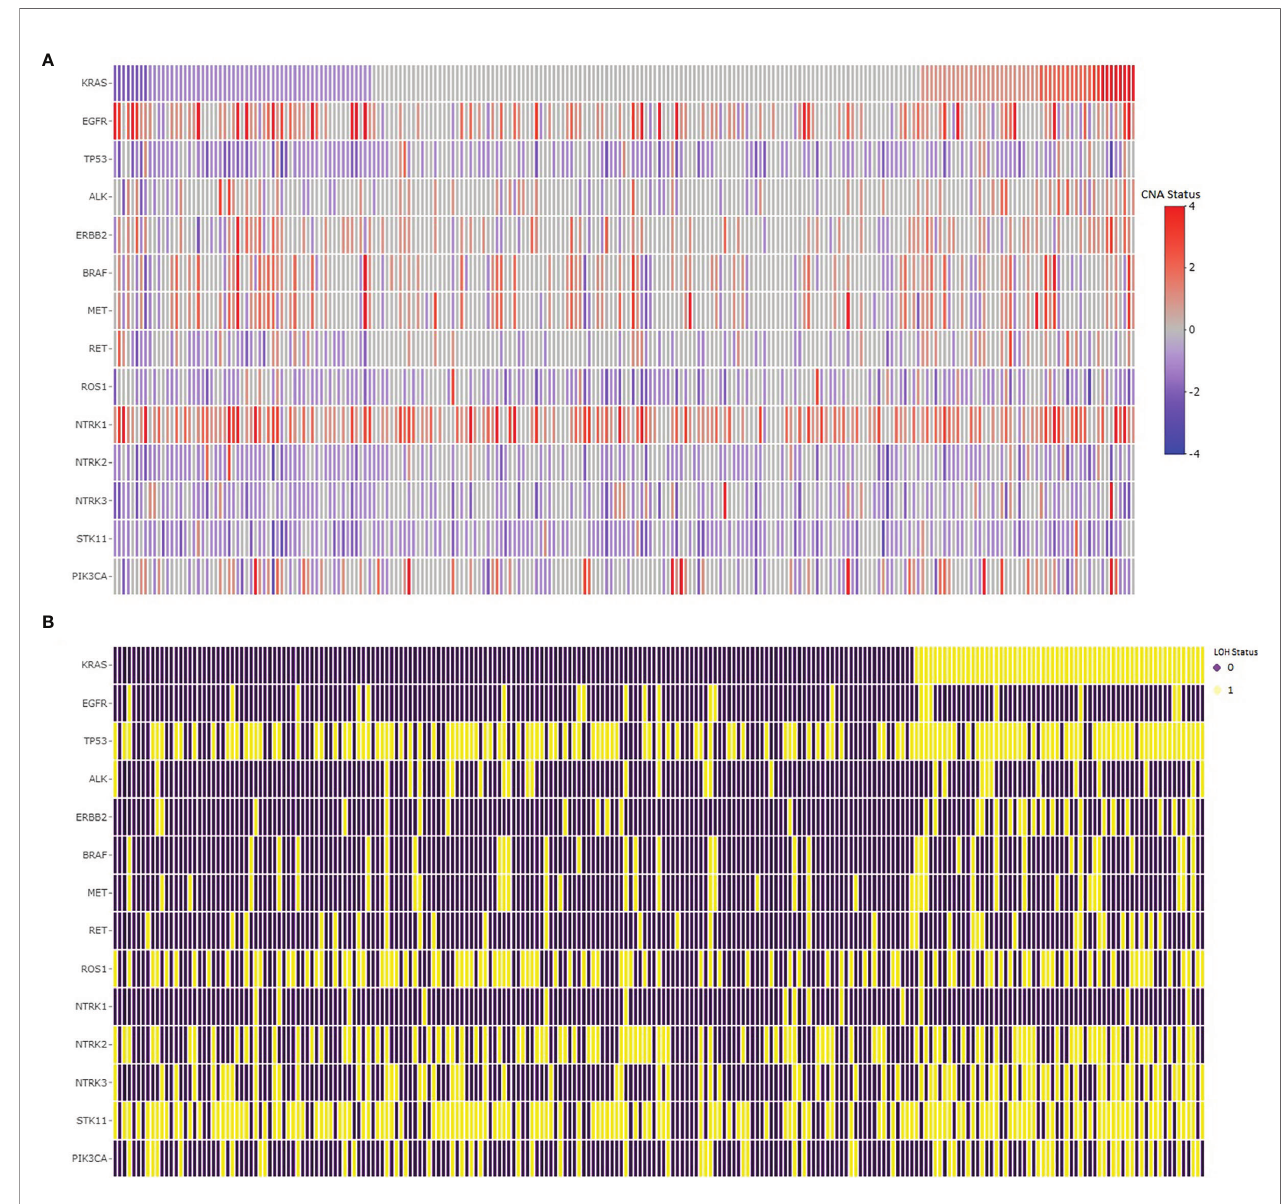
FIGURE 3 | Copy number changes (A) and LOH (B) in common hotspots in lung adenocarcinomas. (A) The copy number changes in the hotspot gene regions sorted by copy number changes in the KRAS gene, where the red color represents copy number gain, whereas the blue color represents copy number loss in the regions. (B) The loss of heterozygosity in the hotspot gene regions, where the purple color shows no loss, whereas the yellow color represents loss of heterozygosity in the